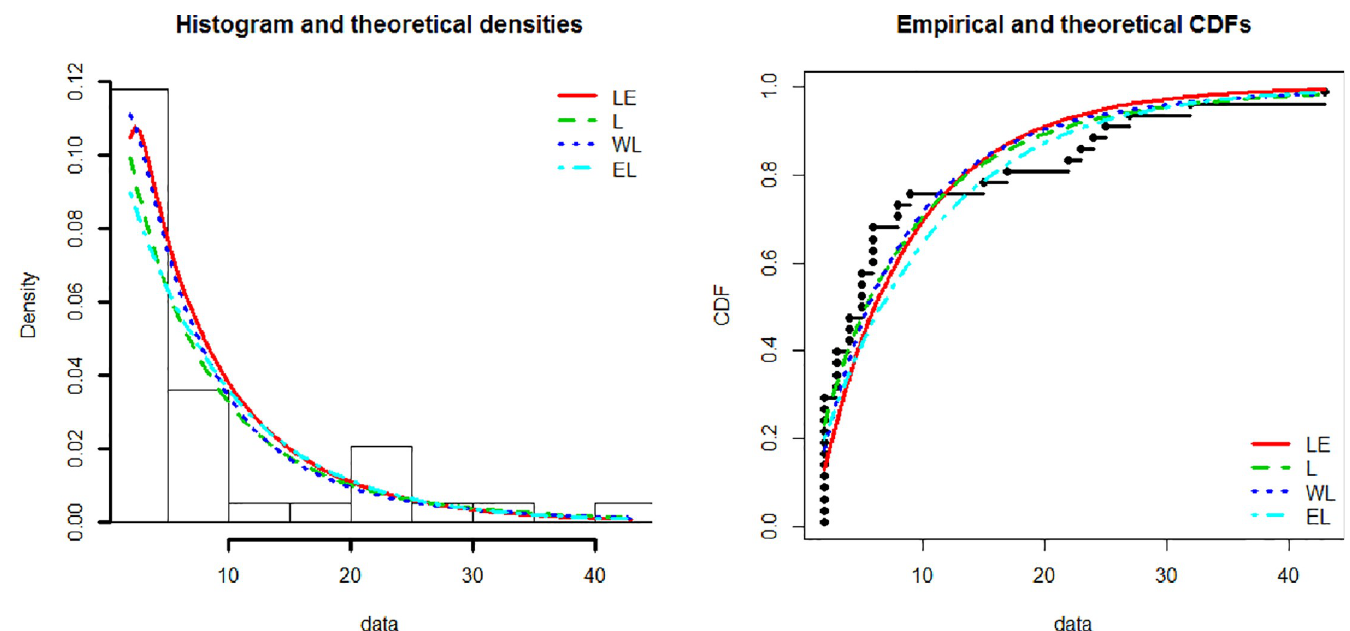
Fig 3. Theoretical and empirical Pdf and Cdf of LE for data set